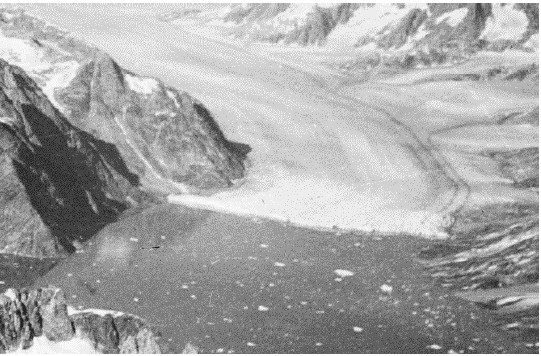
Figure 19. The Knud Rasmussen Glacier in a historical photo (detail); unfortunately, from this photo, it is not possible to get 3D information (only the glacier delimitation).